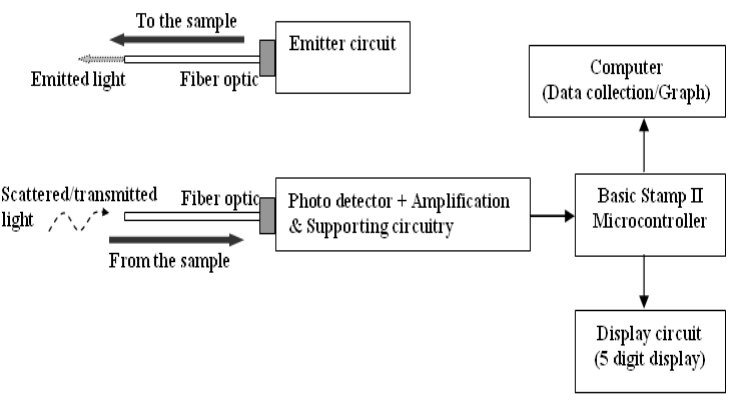
Figure 8. Illustration of Overall Design Concept [54].